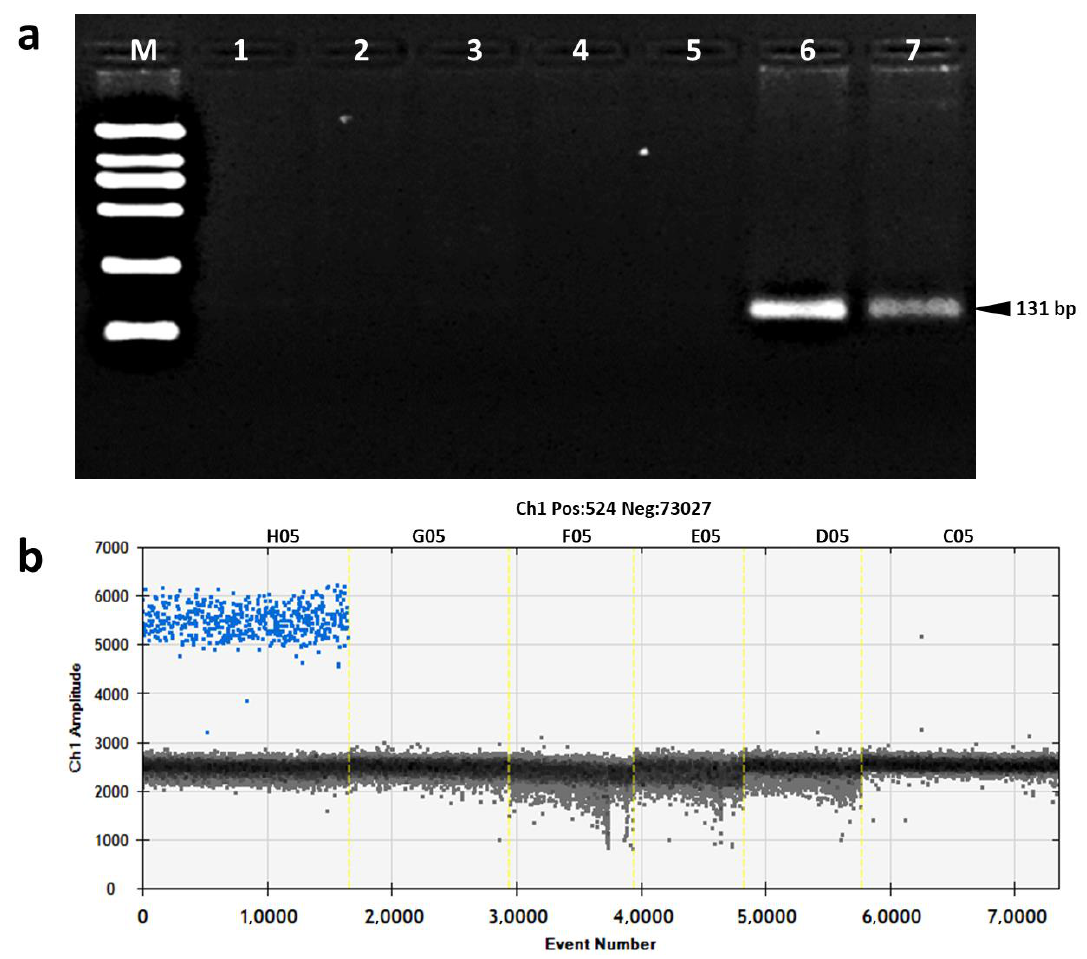
Figure 2. Specificity test of event-specific primer/probe set using qualitative PCR and ddPCR. ( a ) Agarose gel electrophoresis. Lane M, DL2000 DNA marker which contains six DNA fragments with lengths of 2000, 1000, 750, 500, 250, and 100 bp, respectively; lane 1: GM hLZ goat; lane 2: GM hLF goat; lane 3: GM hSA goat; lane 4: non GM goat; lane 5: no template control; lanes 6–7: KoP1 event. ( b ) Droplet readout of ddPCR. H05: KoP1 event; G05: GM hLZ goat; F05: GM hLF goat; E05: GM hSA goat; D05: non-GM goat; C05: no template control.